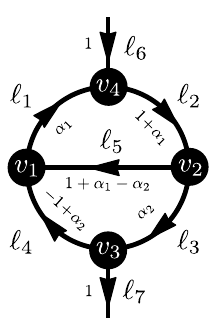
Figure 19 . Two loop diagram with oriented lines ‘ i and vertices v j . The hypercharge of each line is indicated as a function of two free numbers: (cid:11) 1 and (cid:11) 2 . The hypercharge of the external lines was (cid:12)xed to 1 in this